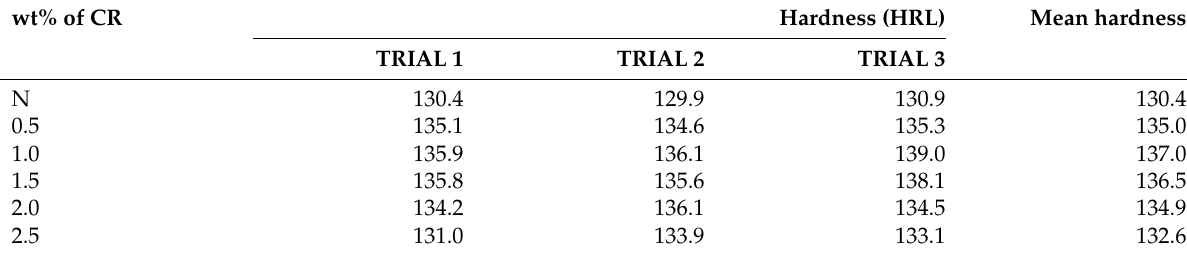
Table 11: Rockwell hardness values on L-Scale for various composition of CFR composite. wt% of